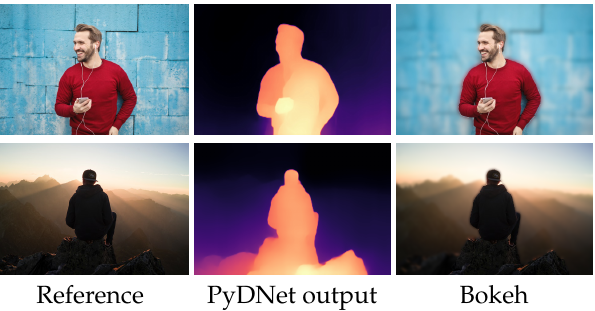
Figure 6. Bokeh effect. Given the reference image, we smooth farther pixels in the image using depth values provided by